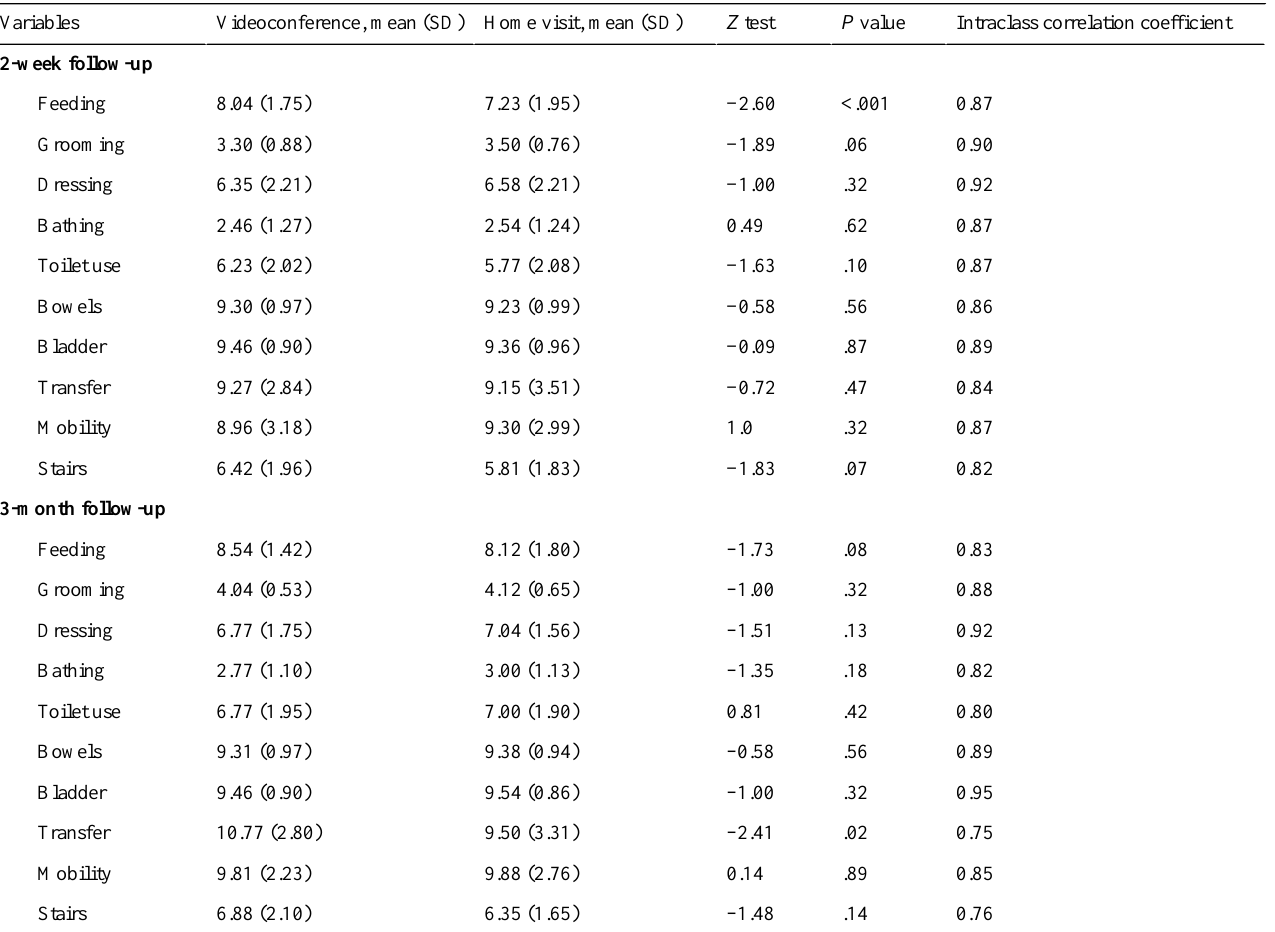
Table 4. A comparison of MBI scores evaluated in videoconference and home visit assessments at 2-week follow-up (n=26) and 3-month follow-up